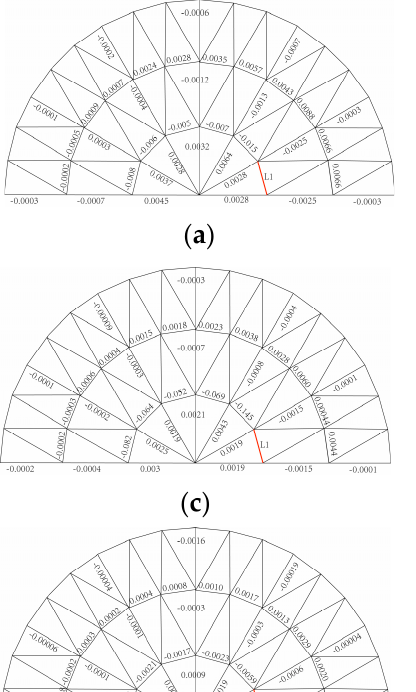
Figure 8. Sensitivity coefficient of the main members when the ring ribs are under different temper- atures. ( a ) t = 20 °C, ( b ) t = 100 °C, ( c ) t = 200 °C, ( d ) t = 300 °C, ( e ) t = 400 °C, ( f ) t = 500 °C.